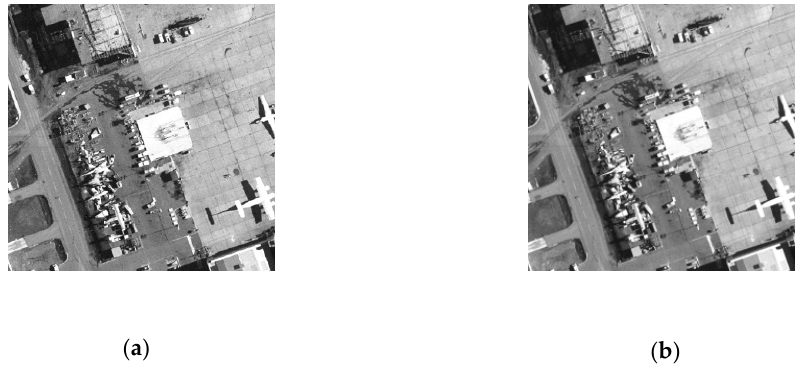
Figure 3. Two images with di ff erent resolutions: ( a ) 512 × 512 pixels and ( b ) 256 × 256 pixels. Table 1. The time taken to compute the microstates and to calculate the absolute Boltzmann entropy for two images of di ff erent sizes, showing the proportion of time spent on the microstates. Time of Computing the Image Total Time (s) Number of Microstates / Total Number of Microstates (s) Time of computing the Time (%)